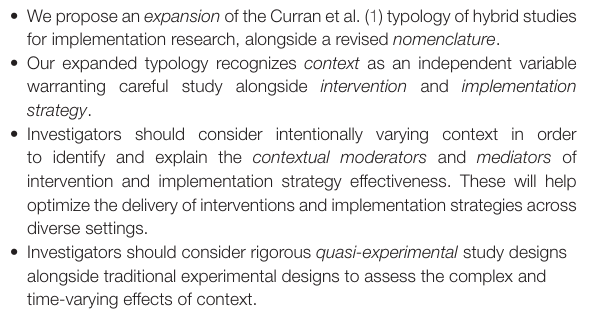
TABLE 2 | Key implications of expanded hybrid